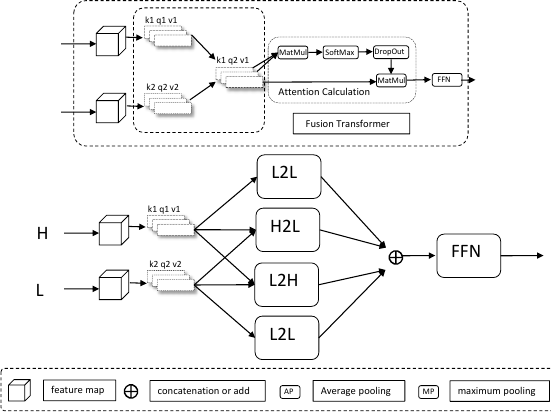
Figure 3. Structure of the FUTR